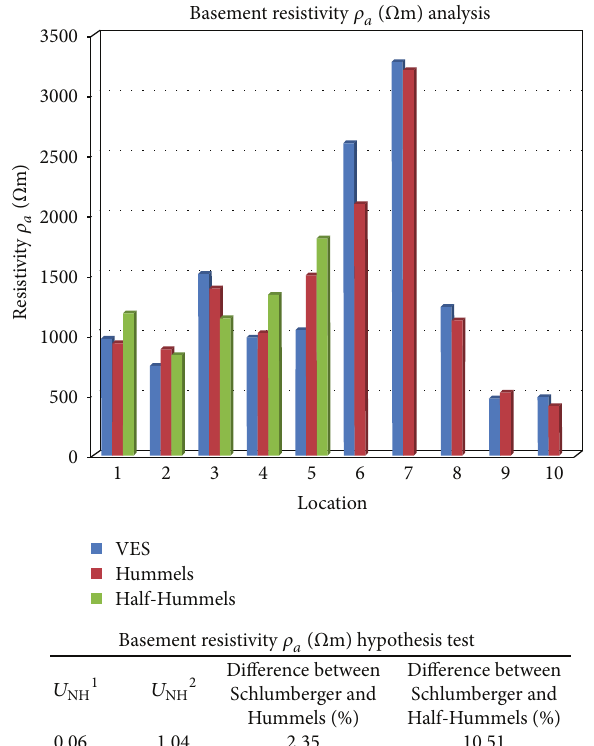
Figure 14: Bar chart and statistical test of hypothesis table for the different array methods comparing basement resistivity for locations on banded gneiss.